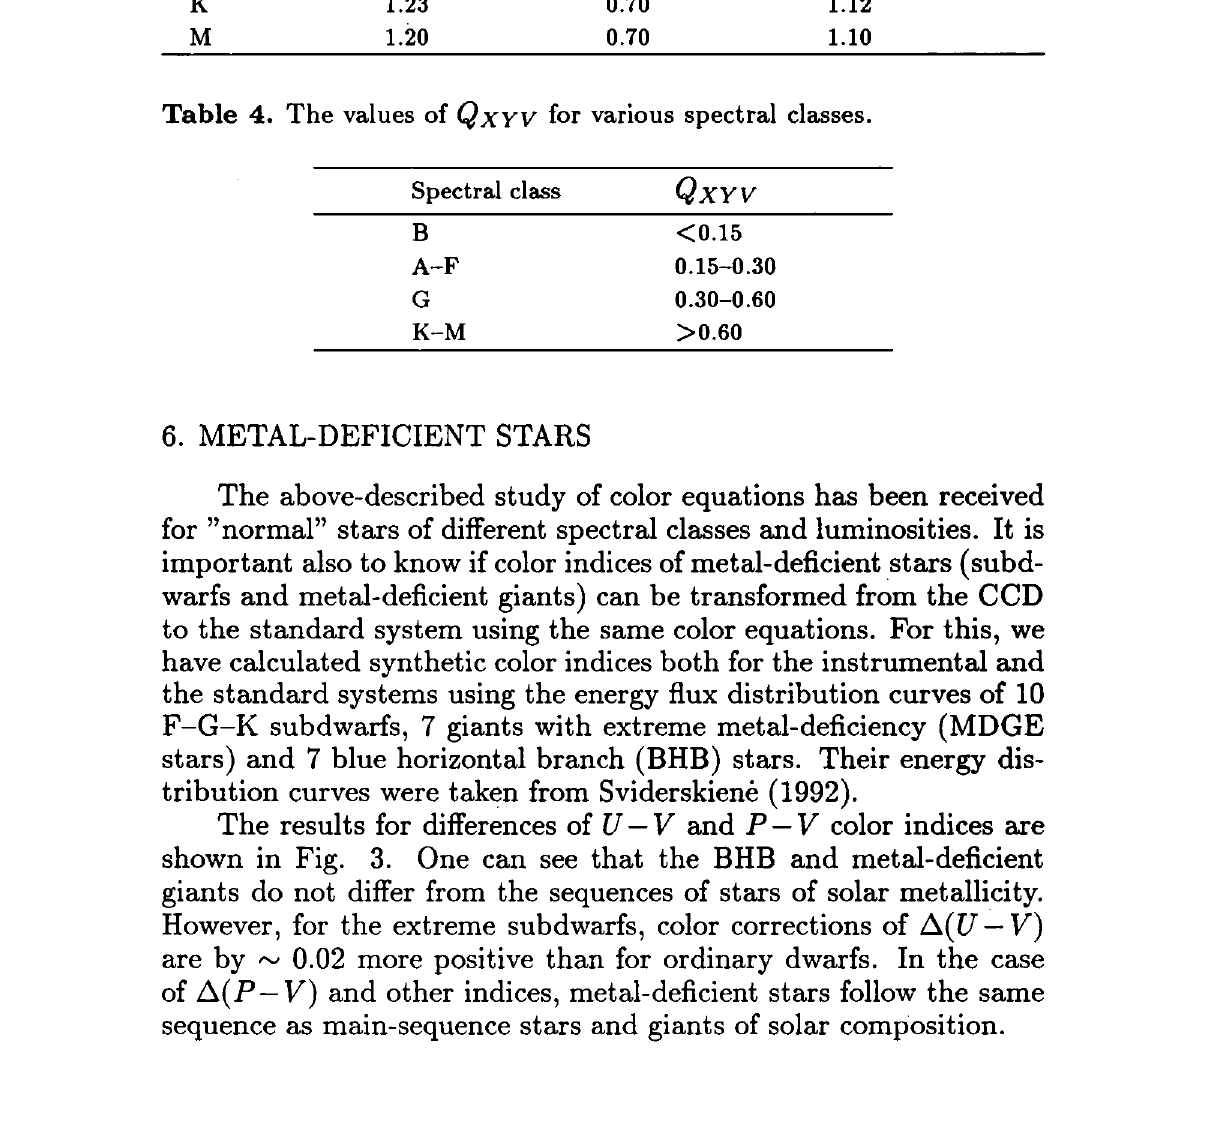
Table 4. The values of QxYV for various spectral